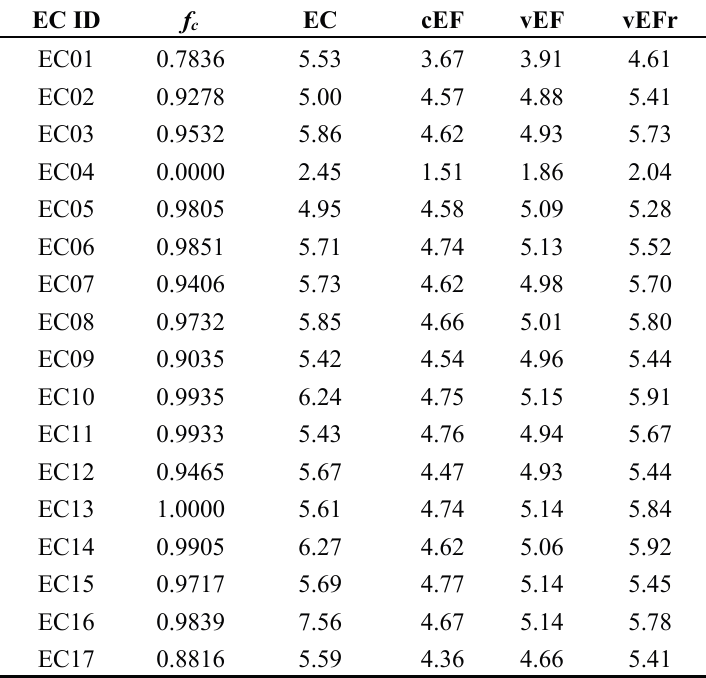
Table 5. ET validation on 2 August of 2012 (units: mm·d − 1